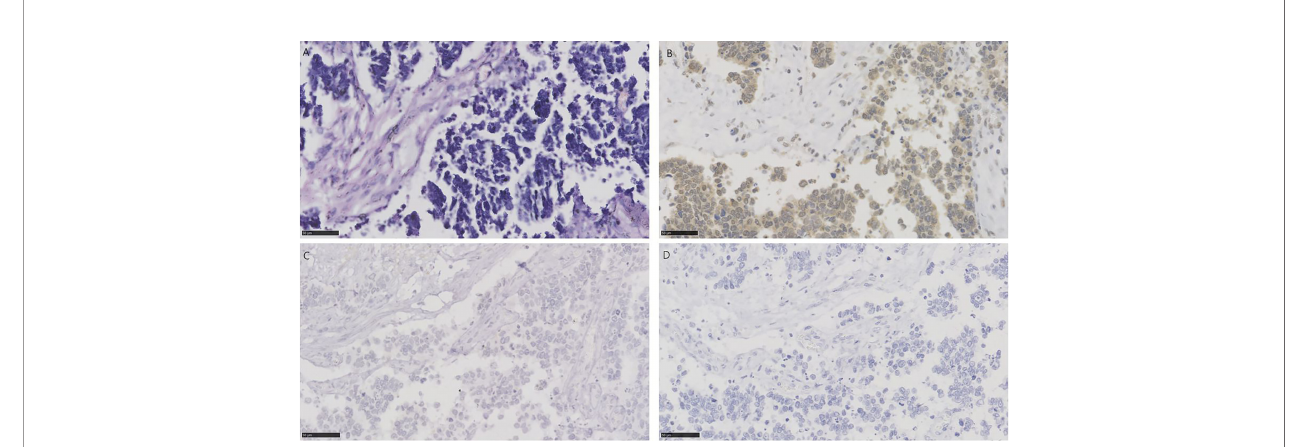
FIGURE 4 | HE and immunohistochemistry for NECTIN-4, TROP-2, and HER2 in urothelial carcinoma with small cell carcinoma. Scale bar: 50 µm. (A) HE-stained section of urothelialcarcinoma with smallcellcarcinoma. (B) Immunohistochemistryfor NECTIN-4 in the same tumor showing moderate staining. (C) Immunohistochemistry for TROP-2 inthe same tumor showingnegative. (D) Immunohistochemistry for HER2 in the same tumor